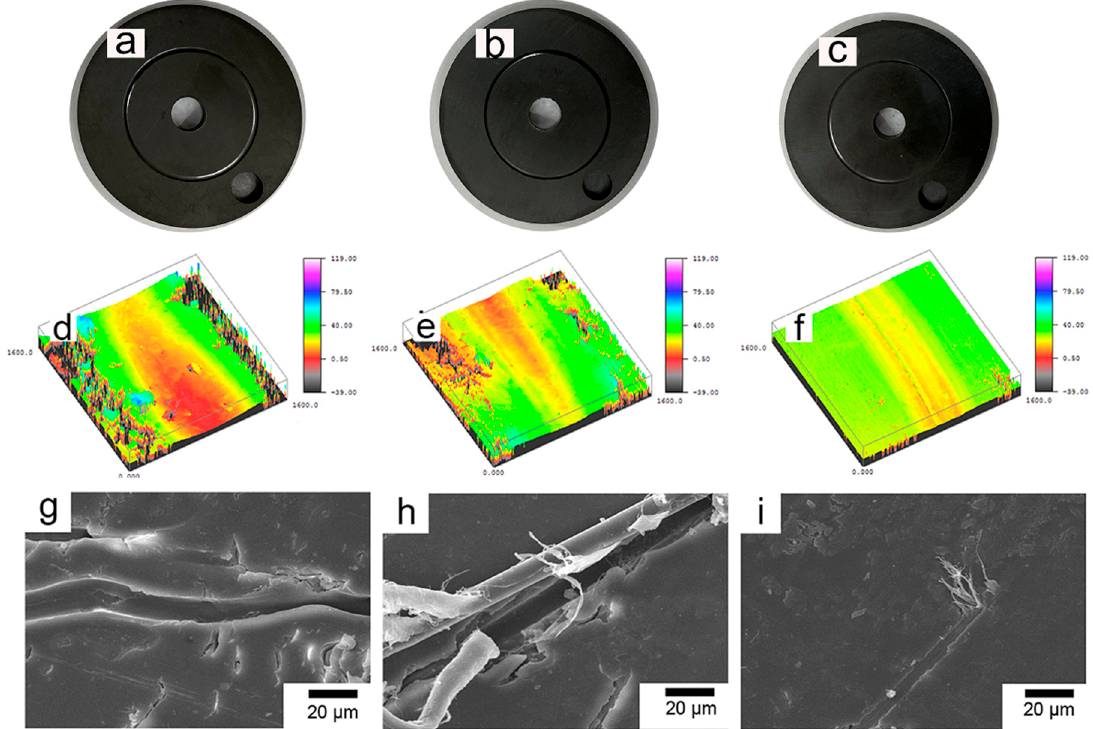
Figure 17. The appearance and SEM photographs of the wear scars of the ( a , d , g ) PBO-Pre / PI, ( b , e , h ) PBO-APTES / PI, and ( c , f , i ) PBO-La / PI composites.